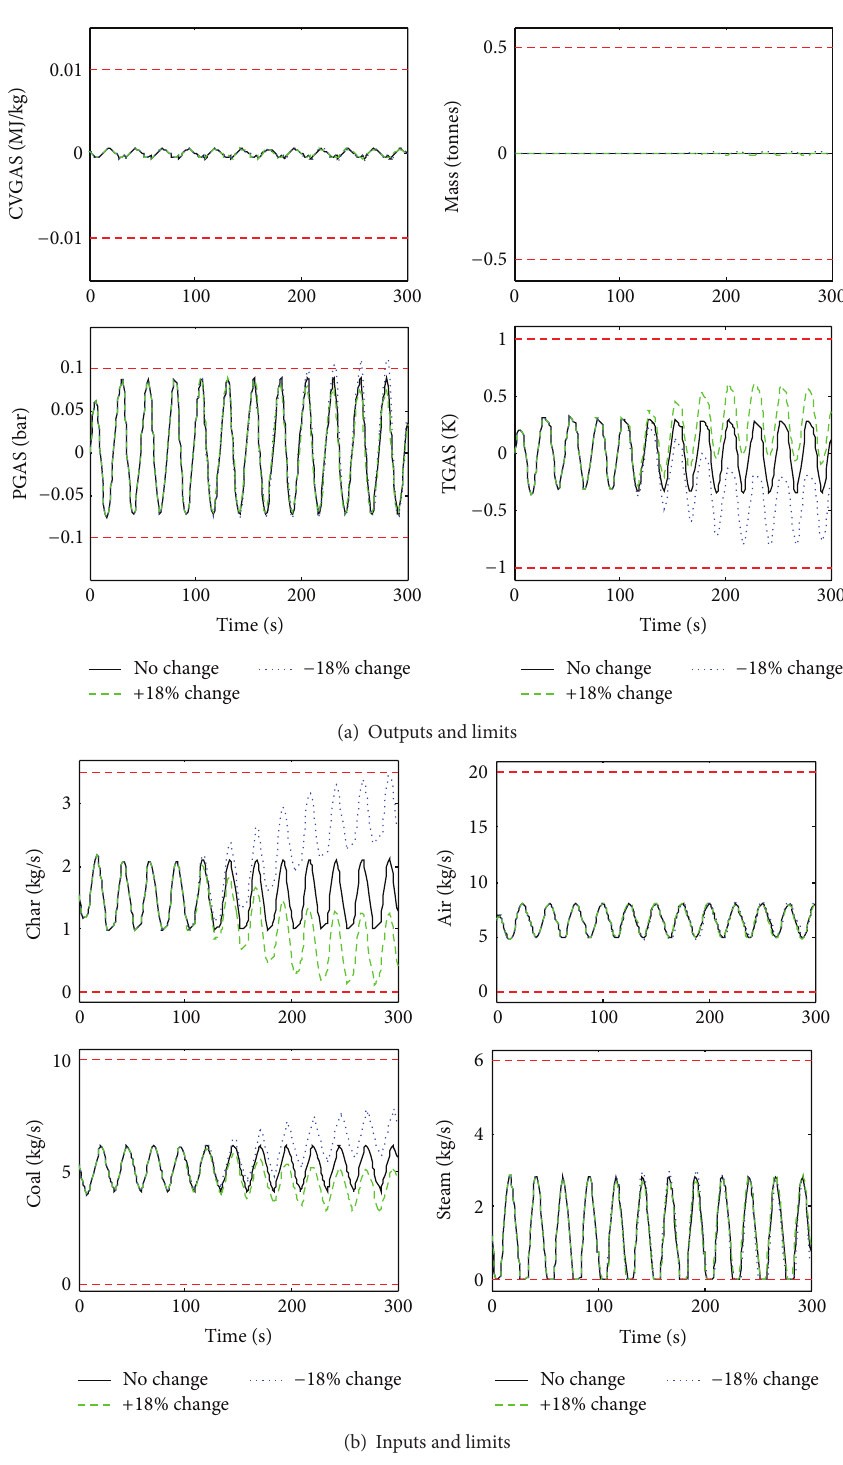
Figure 6: Response to sinusoidal disturbance at 0%